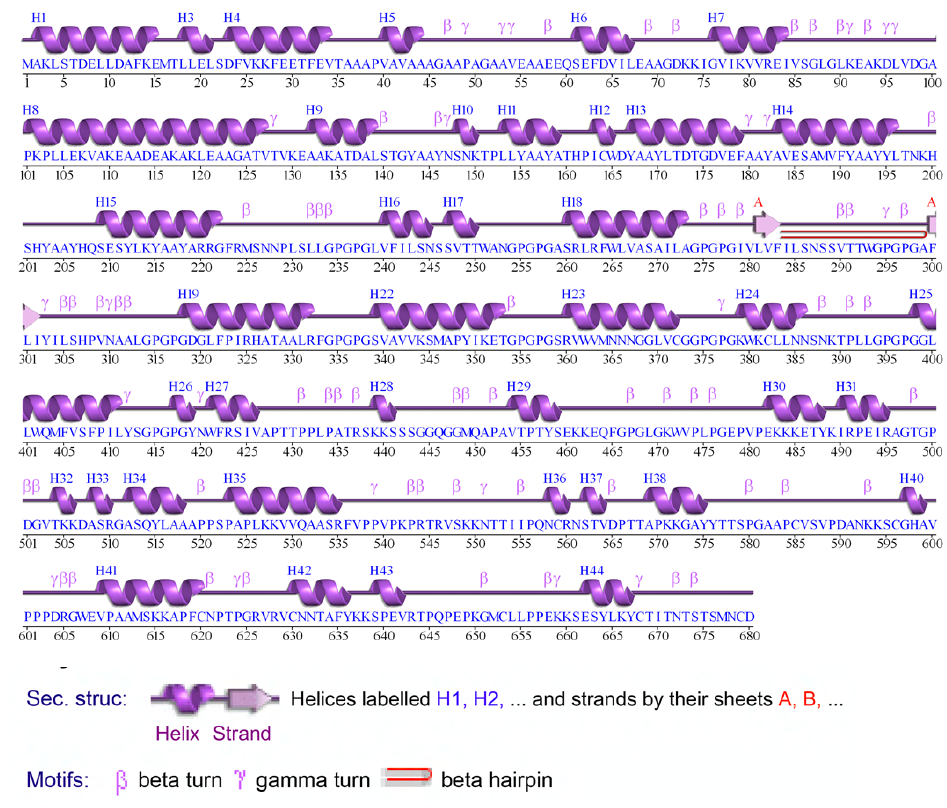
Figure 3. Secondary structure of the predicted vaccine ensemble. The figure shows that helices are interspersed in the vaccine ensemble structure stabilized by beta-sheets and connected by